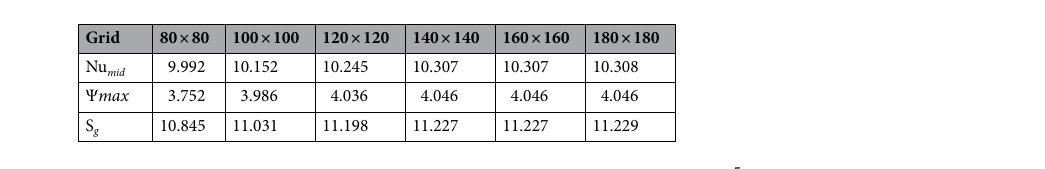
Table 4. The number of grid points for Ha = 20 , φ = 0.03 , and Ra = 10